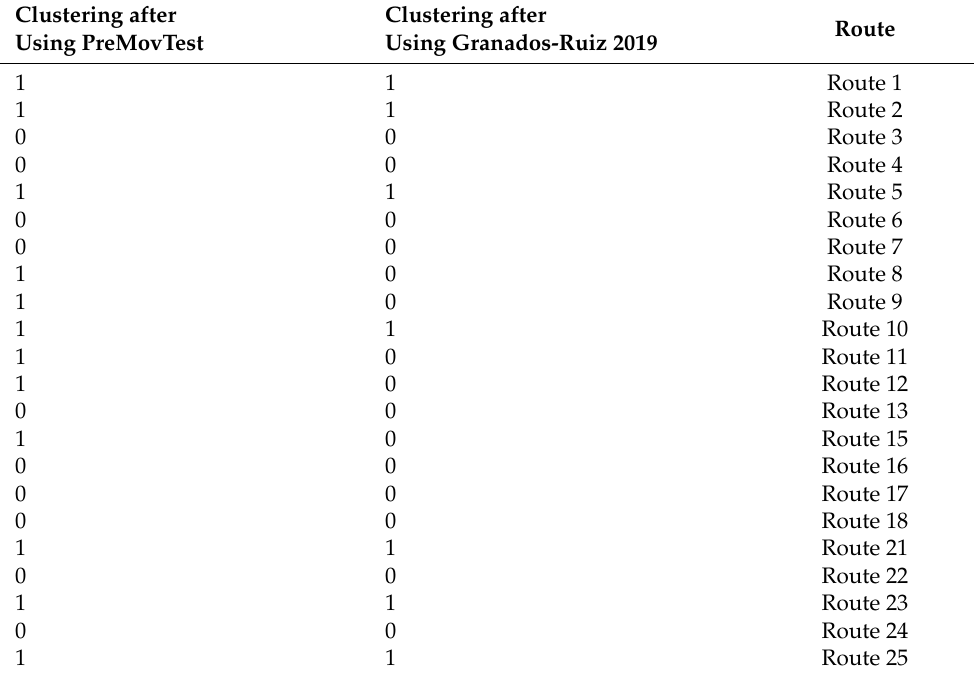
Table 2. The results of route selection for all methods are similar. Clustering after Clustering after Using PreMovTest Using Granados-Ruiz 2019